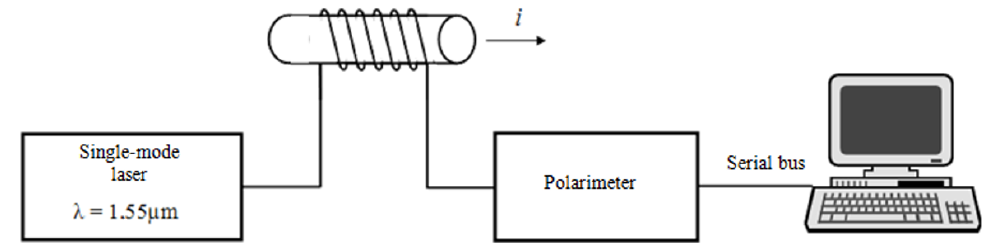
Figure 2. Diagram of the measuring system and the polarimetric current strength probe with the fiber optic measuring coil.